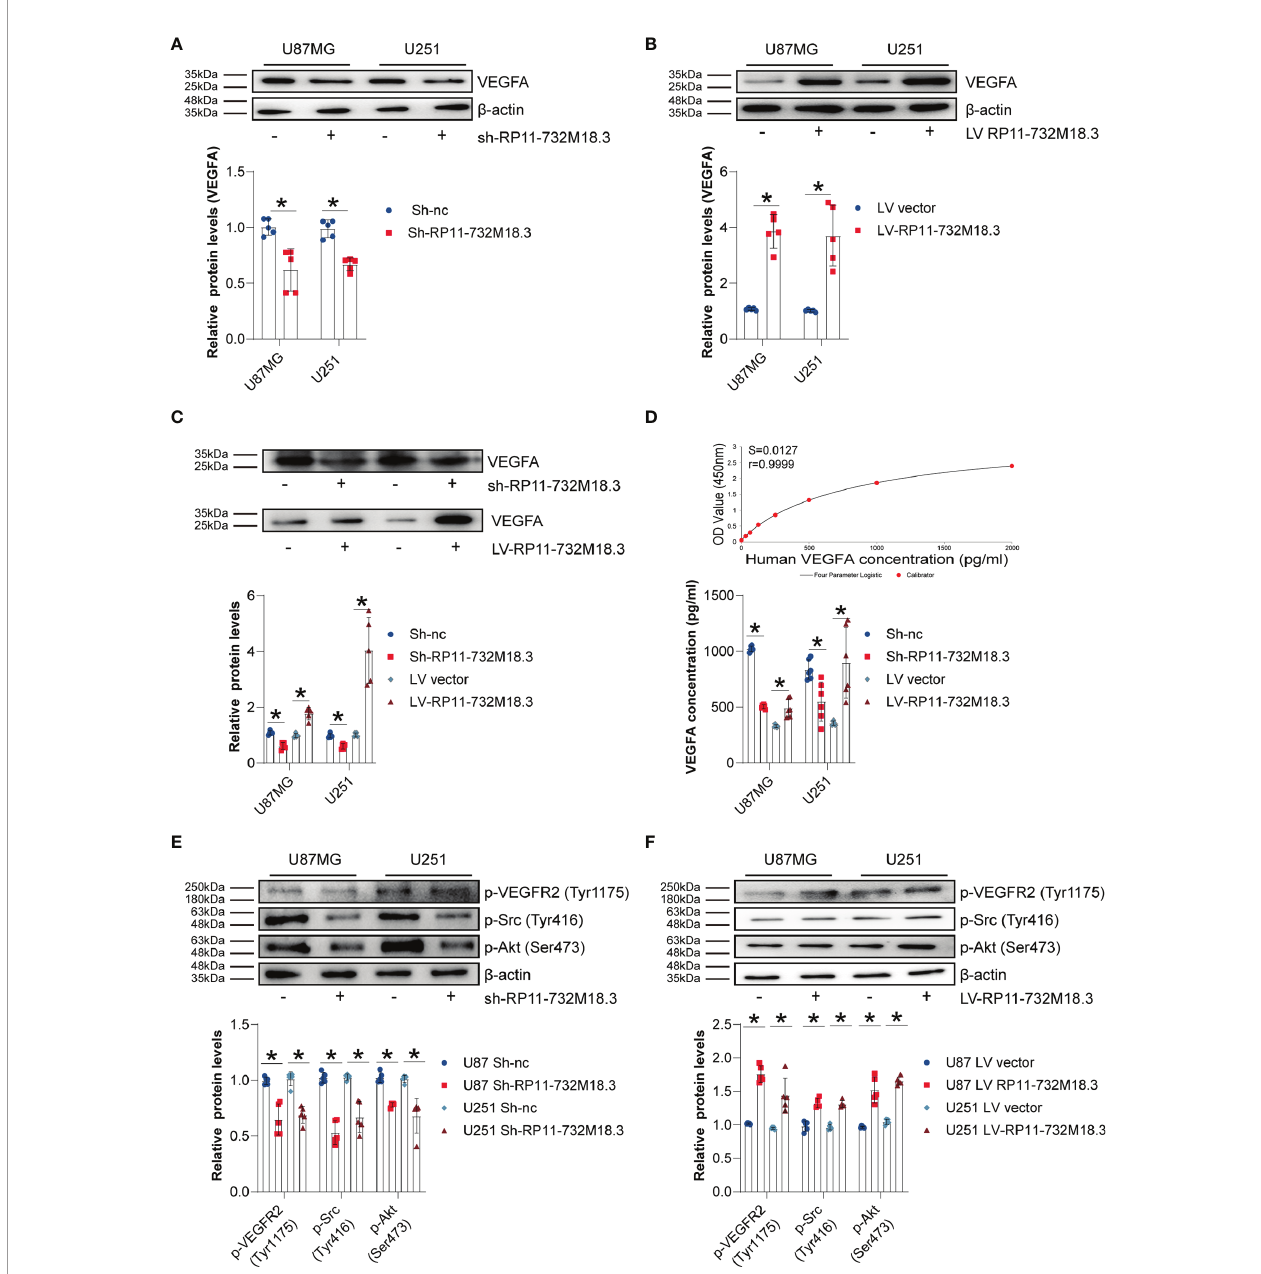
FIGURE 4 | lncRNA RP11-732M18.3 promotes the expression and secretion of VEGFA. (A, B) The expression of VEGFA was detected by western blot (WB) in indicated cells. lncRNA-RP11-732M18.3 increased the expression of VEGFA. All experiments were performed in triplicate (n = 5, * p < 0.05). (C) WB analysis of VEGFA in the concentrated supernatant of indicated cells. An equal volume (45 µL of concentrated supernatants from 5 mL cell culture supernatant) of concentrated supernatant were loaded. All experiments were performed in triplicate (n = 5, * p < 0.05). (D) Supernatant levels of VEGFA were estimated using enzyme-linked immunosorbent assay (ELISA). Upper panel: standard curve; Lower panel: statistical results. All experiments were performed in triplicate (n = 5, * p < 0.05). (E) Activation of the VEGFA downstream signaling pathway was detected using WB in ECs after 48 h of co-culture with lncRNA-RP11-732M18.3 knockdown cells. Knockdown of lncRNA-RP11-732M18.3 decreased phosphorylated VEGFR2 (Tyr1175), Src (Tyr416), and Akt (Ser473). All experiments were performed in triplicate (n = 5, * p < 0.05). (F) Activation of the VEGFA downstream signaling pathway was detected by WB in ECs after 48 h of co-culturing with lncRNA-RP11-732M18.3 overexpressing cells and lncRNA-RP11-732M18.3 knockdown cells. Overexpression of lncRNA-RP11-732M18.3 increased phosphorylated VEGFR2 (Tyr1175), Src (Tyr416), and Akt (Ser473). All experiments were performed in triplicate (n = 5, * p <